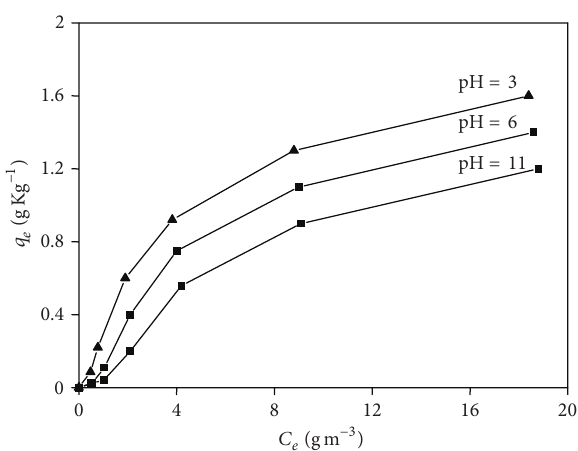
F 8: Equilibrium adsorption of methylene blue on